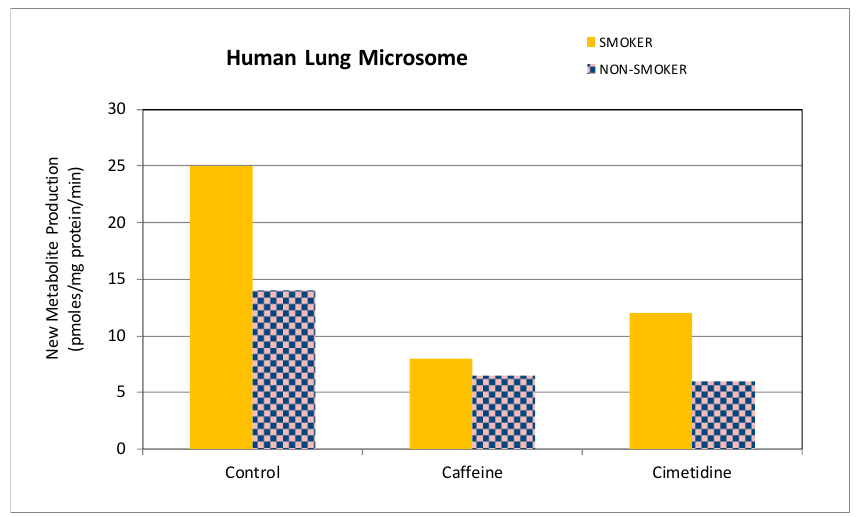
Figure 4. Inhibition of theonosine production by caffeine and cimetidine in human lung microsomes.